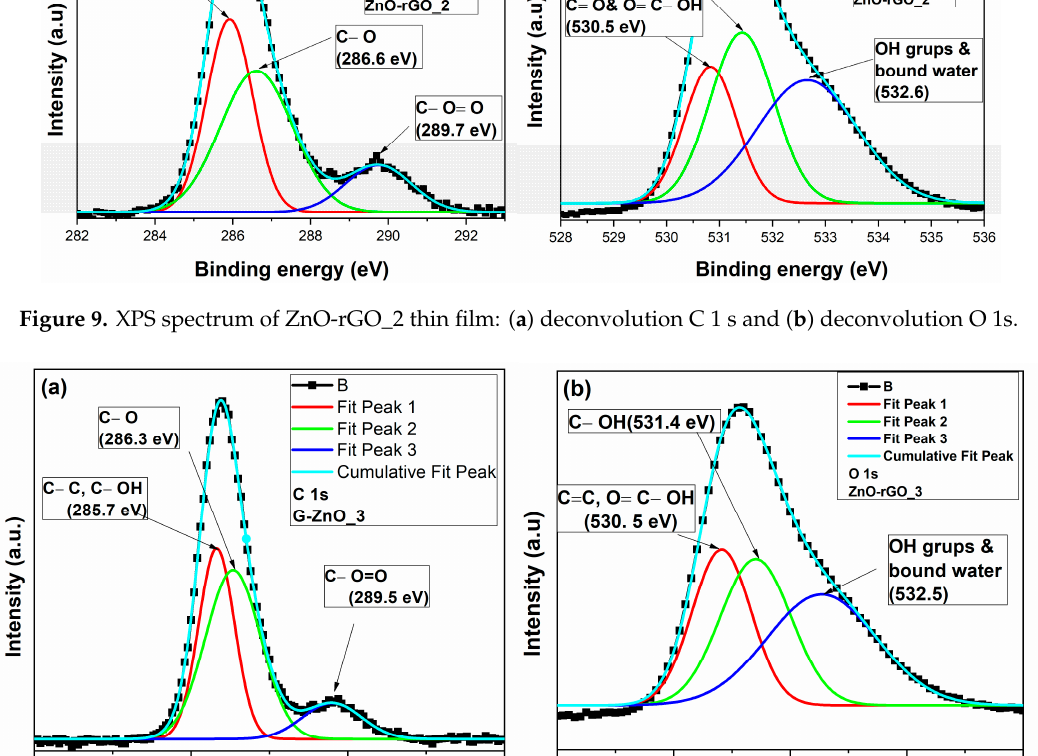
Figure 10. XPS spectrum of ZnO-rGO_3 thin film: ( a ) deconvolution C 1 s and ( b ) deconvolution O 1 s.